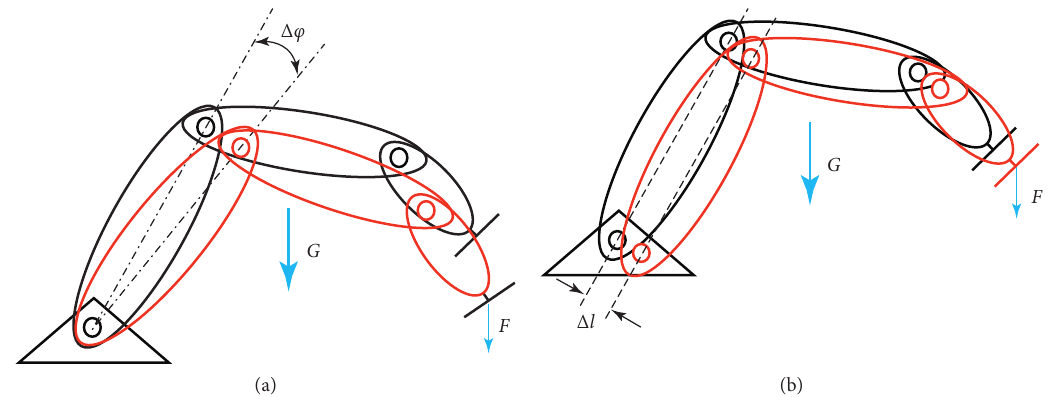
Figure 1: Two types of deformation at the joint. (a) The rotary deformation at the joint. (b) The linear deformation at the